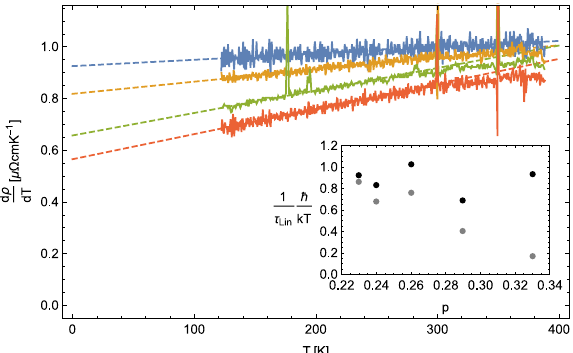
Fig. 3 Temperature derivative of the resistivity for mildly over- doped LSCO. From top to bottom p = 0.19, 0.20, 0.21, and 0.22. Data from 22 . Dashed lines are fi ts to a + 2 bT . The inset shows the merging of the higher-temperature (upper, black dots) and lower- temperature (lower, gray dots) T -linear scattering rates as doping is reduced. Data for the inset from 45 , with the timescale expressed in Planckian units following 16